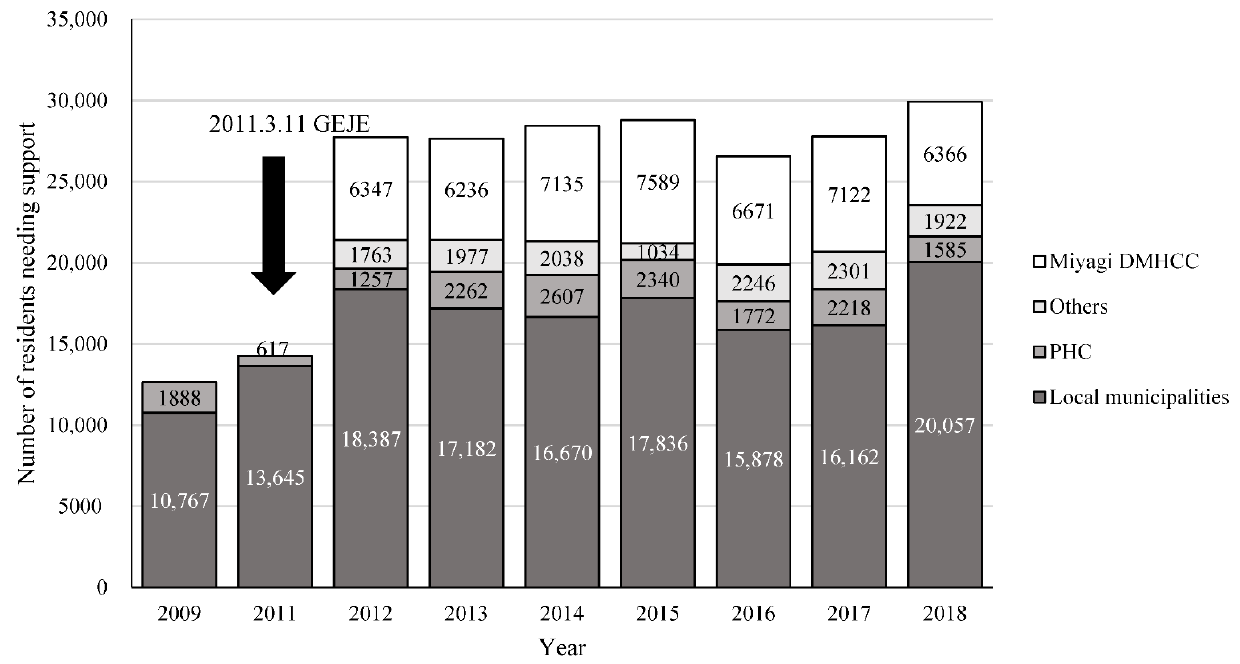
Figure 1. The cumulative number of mental health support cases in Miyagi prefecture from 2009 to 2017 across different organizations. GEJE, Great East Japan Earthquake; PHC, Public Health Center.